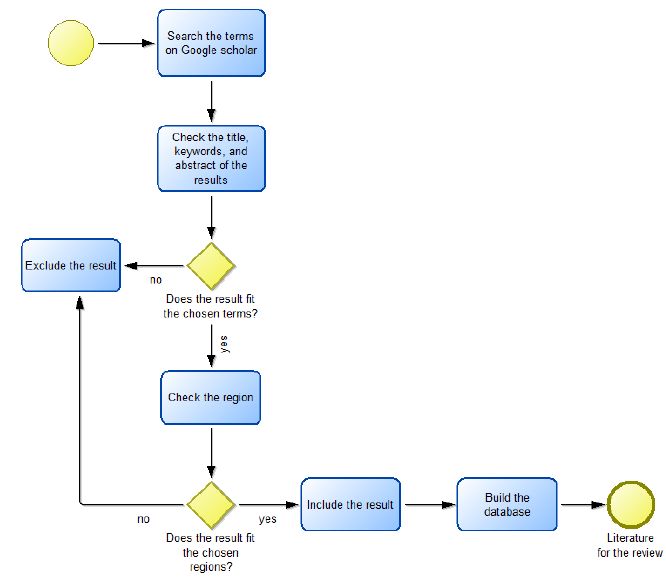
Figure 1. Flowchart of the literature search process.